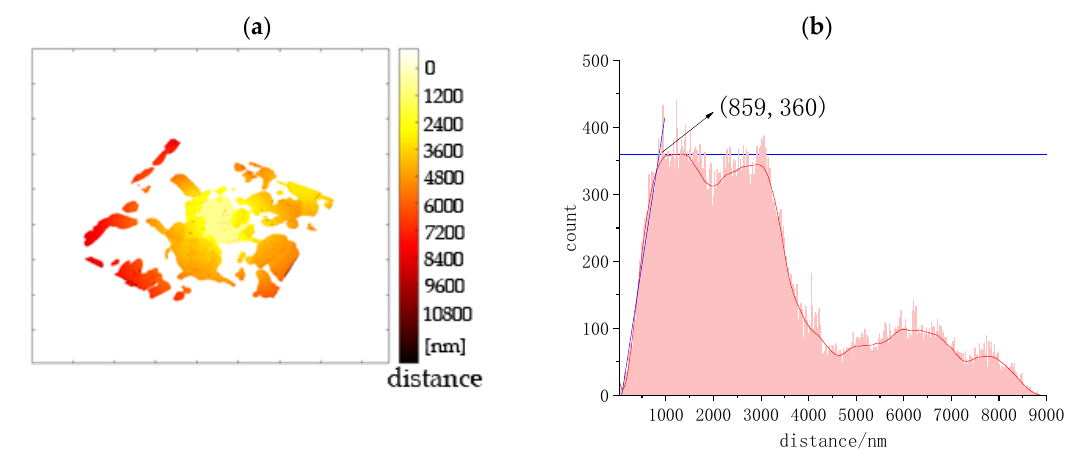
Figure 6. Distance of capillary pores from the surface of the anhydrous C 3 S particle qualitatively ( a ) and quantitatively displayed ( b ). Table 1. The critical distance from pores to anhydrous particles.